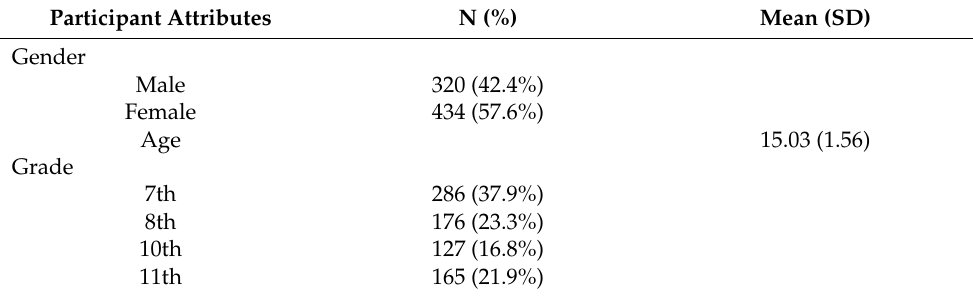
Table 1. Participant attributes in the present study.